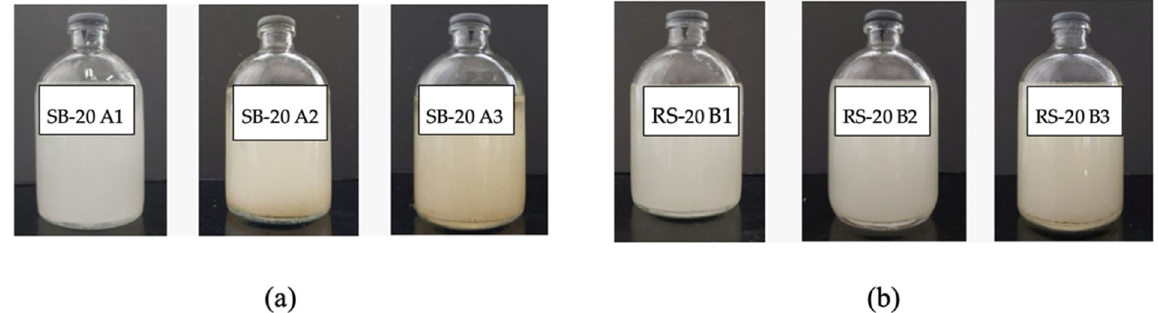
Figure 1. CNC products from ( a ) pretreated sugarcane bagasse (SB ‐ 20) and ( b ) pretreated rice straw (RS ‐ 20). The CNS synthesis from SB ‐ 20 using TEMPO and various moles of NaOCl, i.e., 11, 9, and 7 moles gives SB ‐ 20 A1, SB ‐ 20 A2, SB ‐ 20 A3, respectively, and RS ‐ 20 gives RS ‐ 20 B1, RS ‐ 20 B2, and RS ‐ 20 B3, respectively.